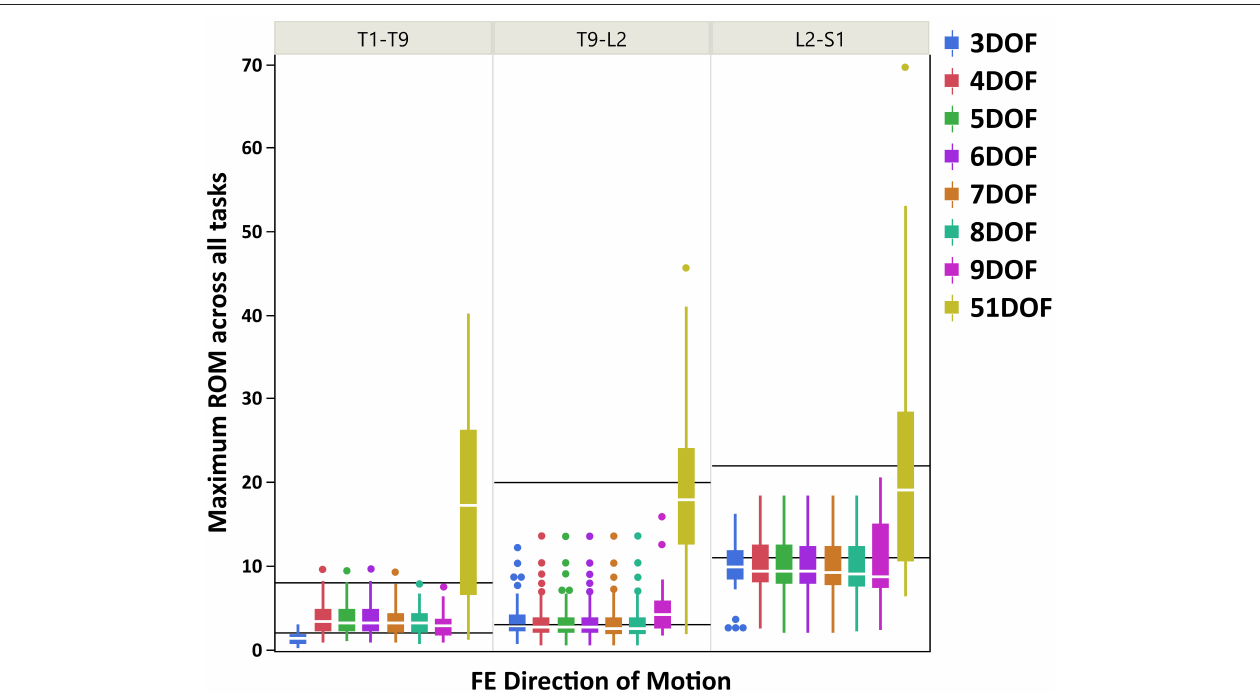
FIGURE 3 | Boxplot of maximum ROM of 17 intervertebral joint angles, grouped in three spine regions [i.e., “T1-T9”: T1/T2 to T8/T9; “T9-L2”: T9/T10 to L1/L2; “L2-S1”: L2/L3 to L5/S1)], for all kinematic constraints [3–9DOF and no constraint (51DOF)] in FE direction of motion. The black lines horizontally overlaid on each panel plot are minimum and maximum ROM of intervertebral joints for the corresponding spine regions in FE direction of motion, reported by White and Panjabi (1978). ROM, range of motion; DOF, degrees of freedom; FE,